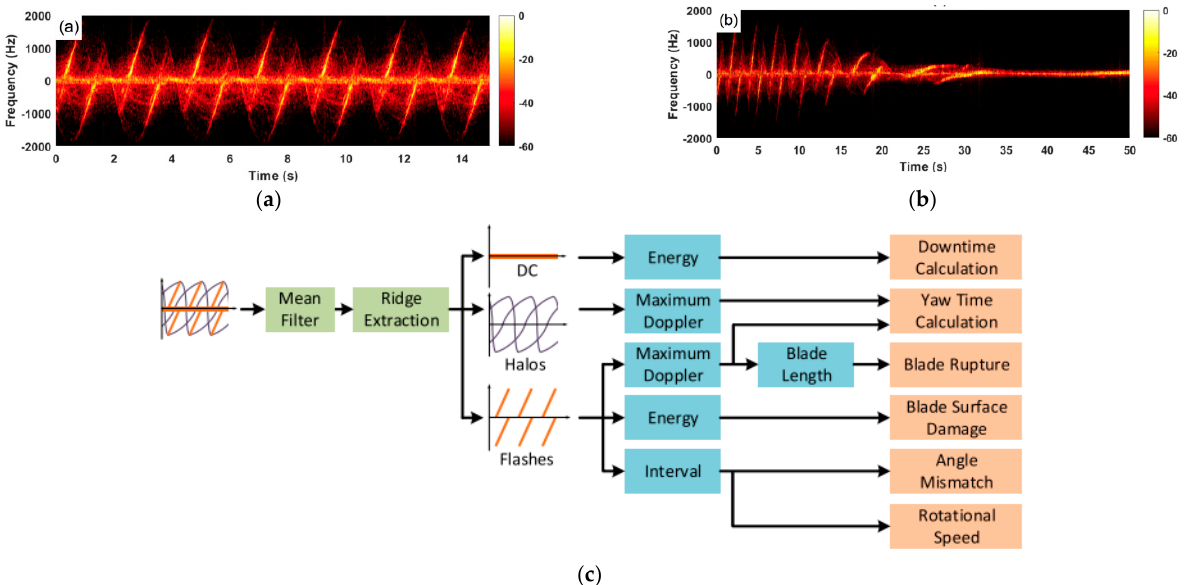
Figure 13. SHM of a onshore wind turbine: ( a ) spectrogram when the turbine is fully operational; ( b ) spectrogram when the blade rotation is gradually stopping; ( c ) flowchart of the proposed strategy for the SHM of a wind turbine. Reprinted with permission from ref. [94]. Copyright 2021 IEEE.